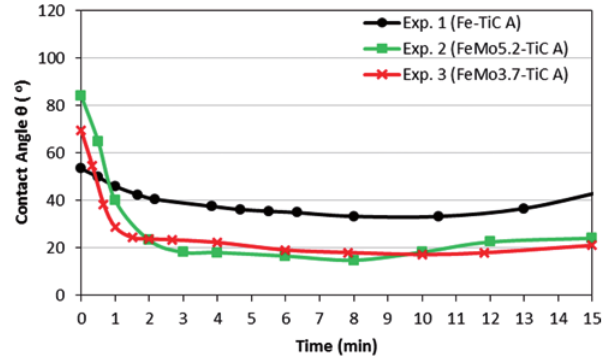
Fig. 1: Contact angles vs. time in type A experiments